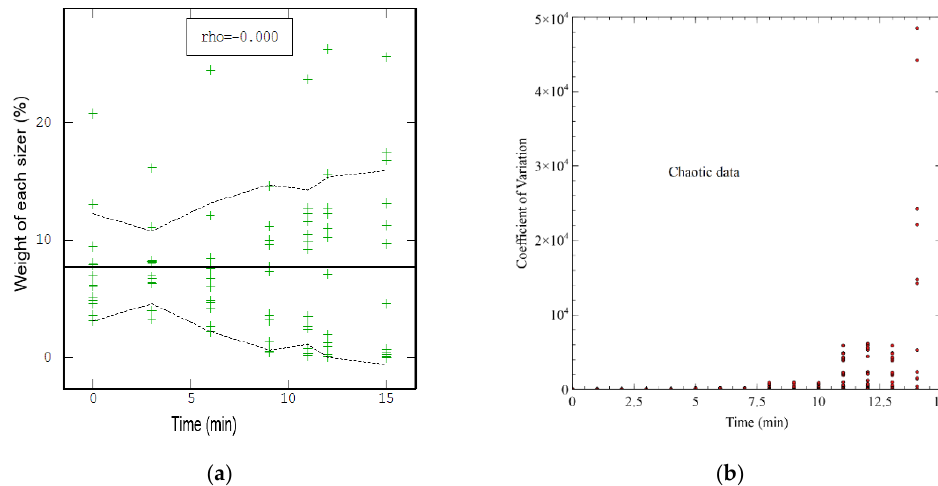
Figure 14. Results for LGP-1 for ore-B for time evolutions: ( a ) weight of each sizer fluctuation zone of the reconstructed data; ( b ) 𝐶𝑣 for each time.